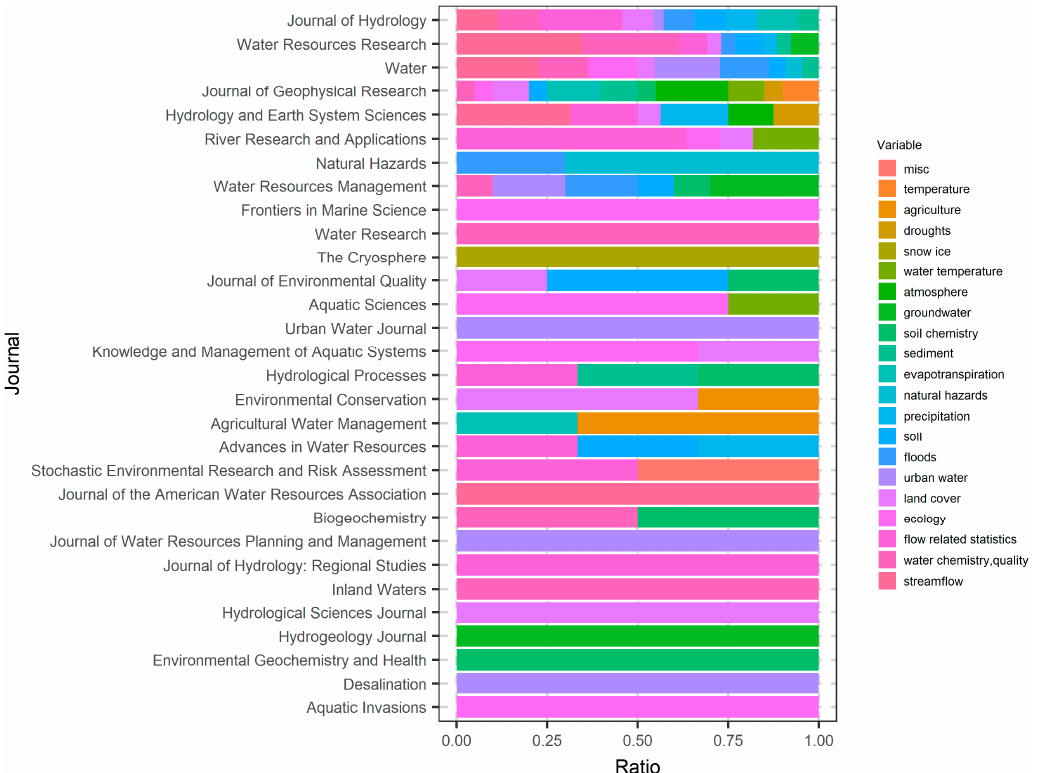
Figure A1. Fraction of papers modeling different variables (see Section 6.1 and Figure 7) conditioned on the Journal. The Journals are ranked in descending order based on the number of published papers on random forests (see Figure 3).